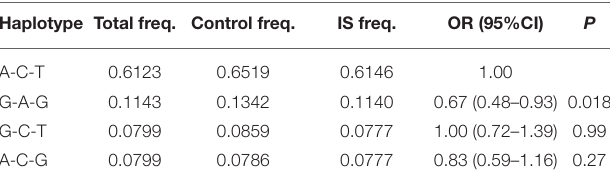
TABLE 4 | Haplotype frequencies among the MOGAT2 rs600626, rs609379 and rs10899104 SNPs and the risk of IS. Haplotype Total freq. Control